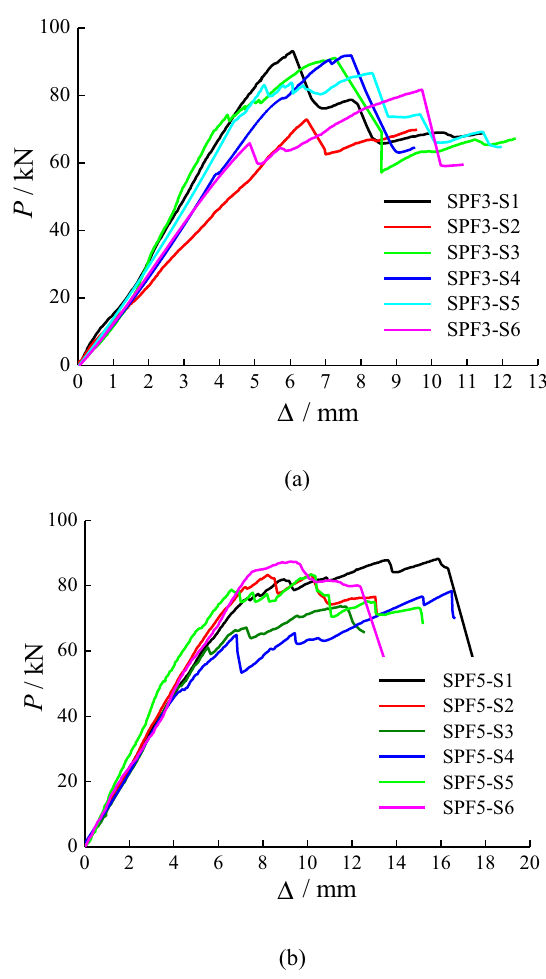
Fig. 7 Load–deflection curves of SPF CLT panels: a 3-layer; 5-layer